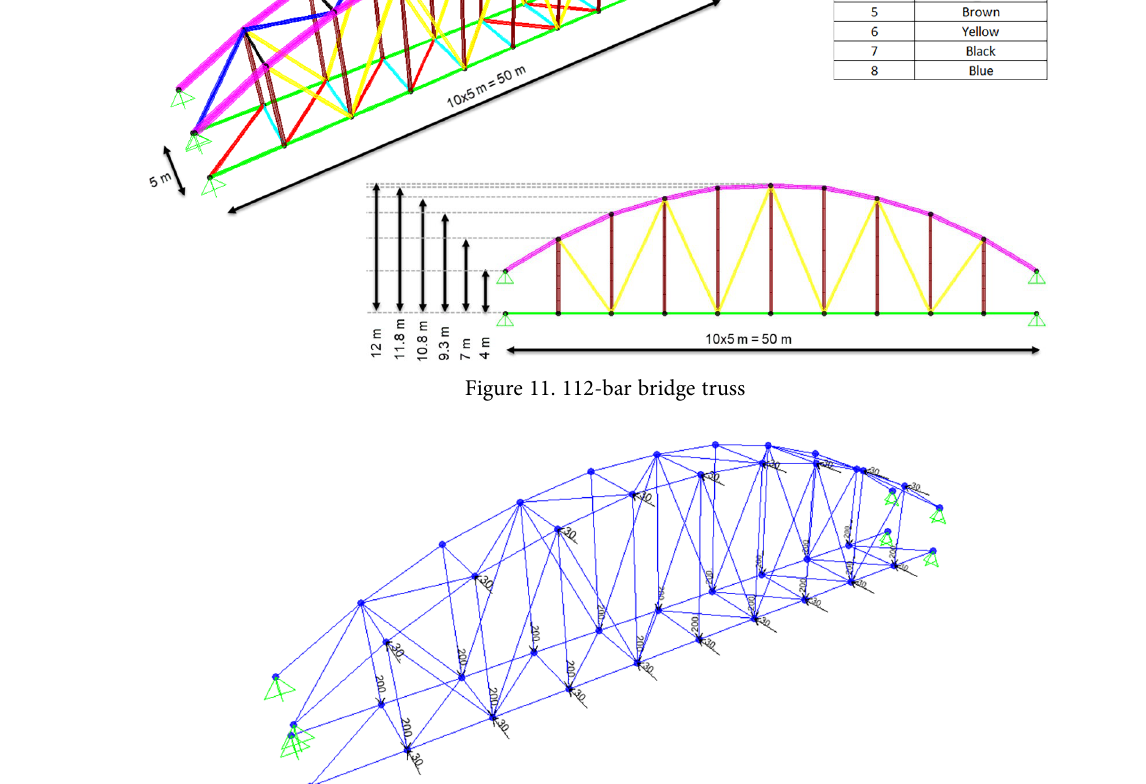
Figure 12. 112-bar bridge truss